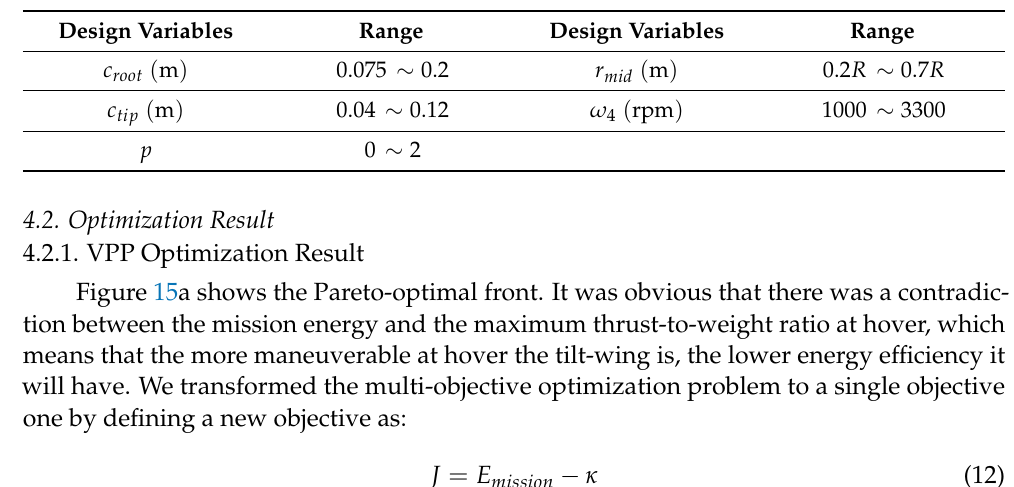
Table 3. Range of design